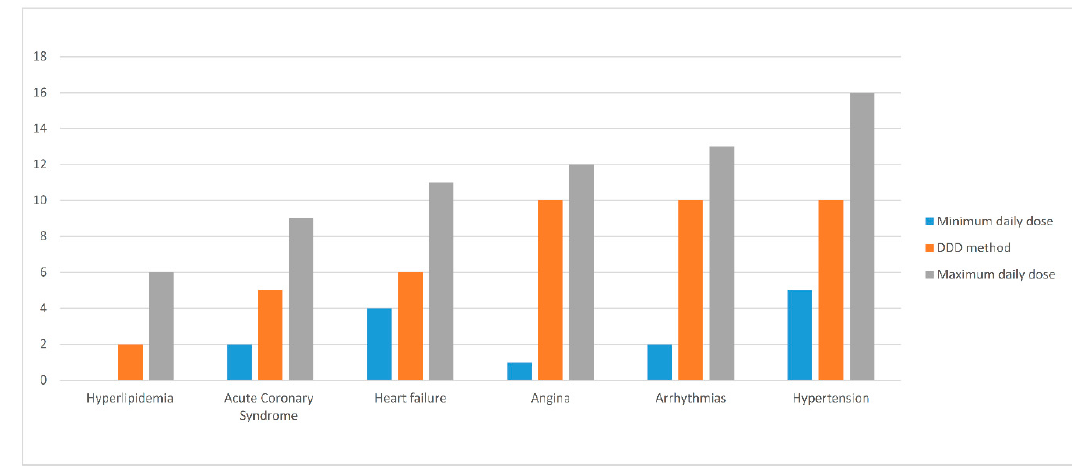
Figure 5. The non-affordable indications in monotherapy scenarios. Figure 5. The non-a ff ordable indications in monotherapy